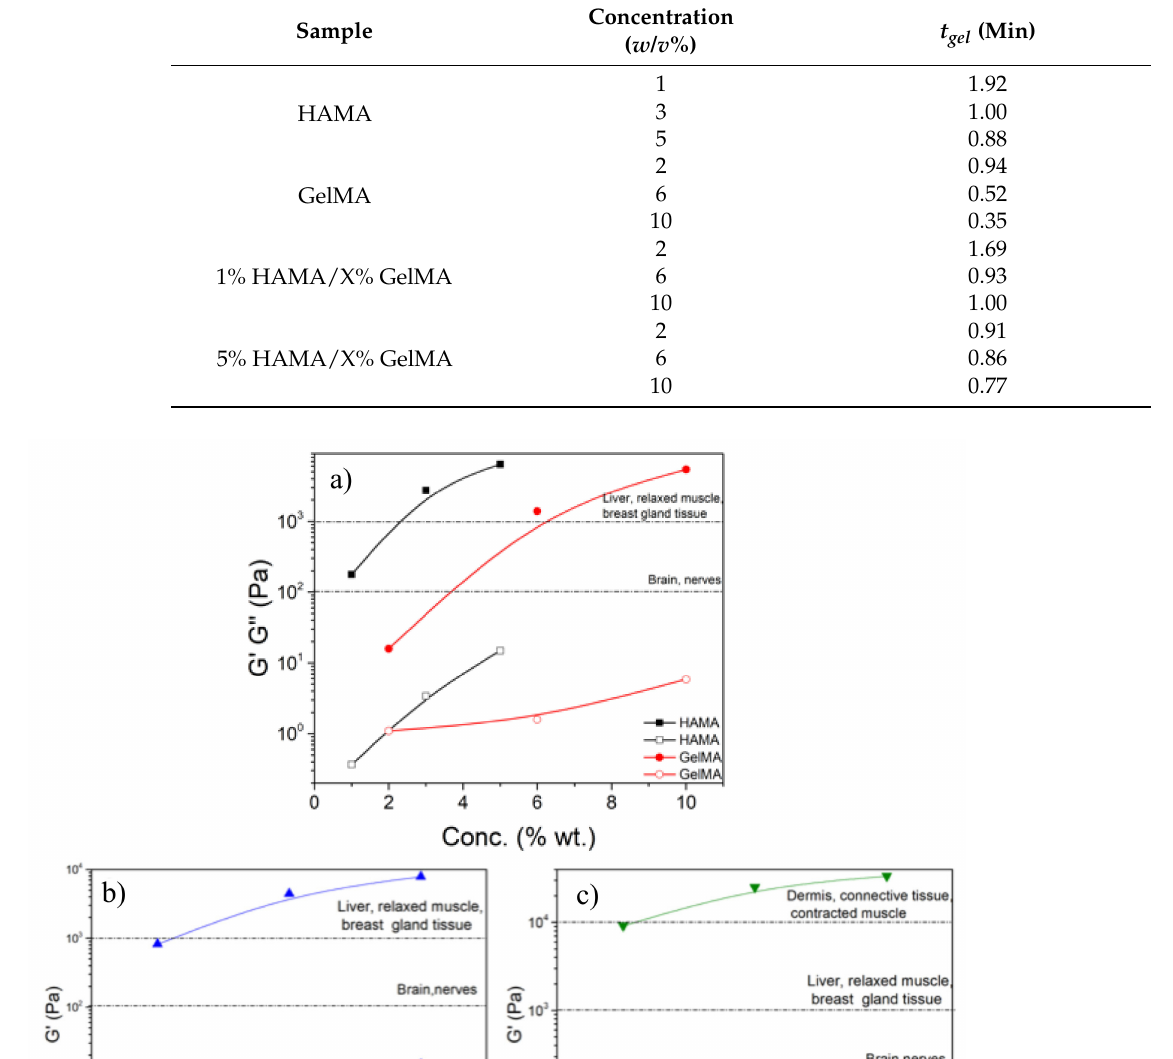
Table A1. Gelation time (t gel ) for HAMA, GelMA, and hybrid HAMA/GelMA hydrogels obtained